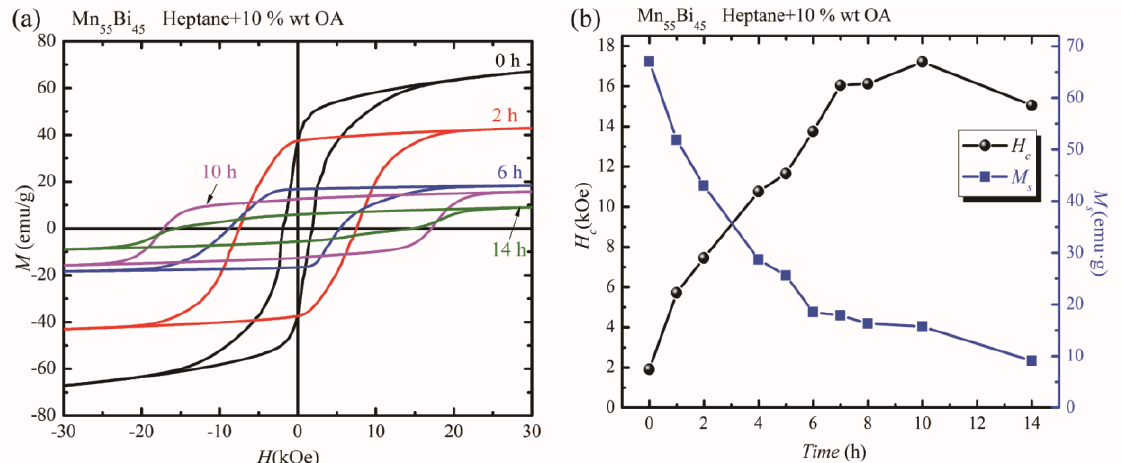
Figure 6. ( a ) Hysteresis loops and ( b ) Variation of coercivity, M s with milling time of Mn 55 Bi 45 powders obtained by SALEBM.